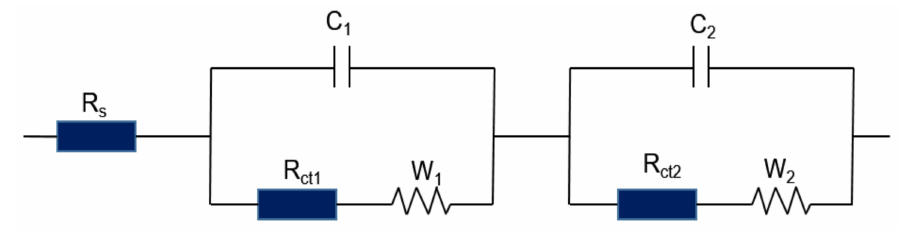
Figure 8. Equivalent